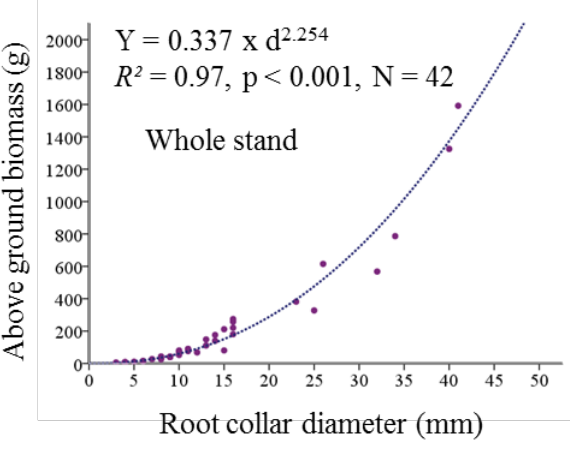
Figure 10. Regression model for above ground biomass equation of the dead trees. Above ground biomass (Y) is modeled as the power function of the diameter at root collar (d). Above ground biomass was measured in grams and the diameter at root collar in millimeters